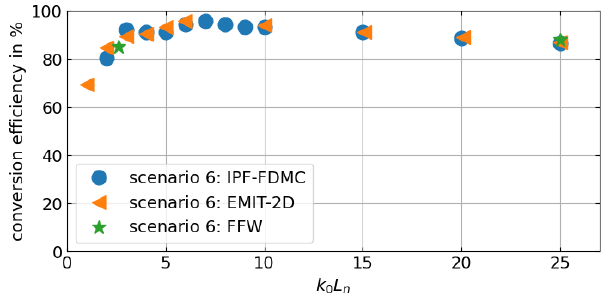
Figure 10. O-SX conversion e ffi ciency obtained from full-wave simulations as a function of k 0 L n